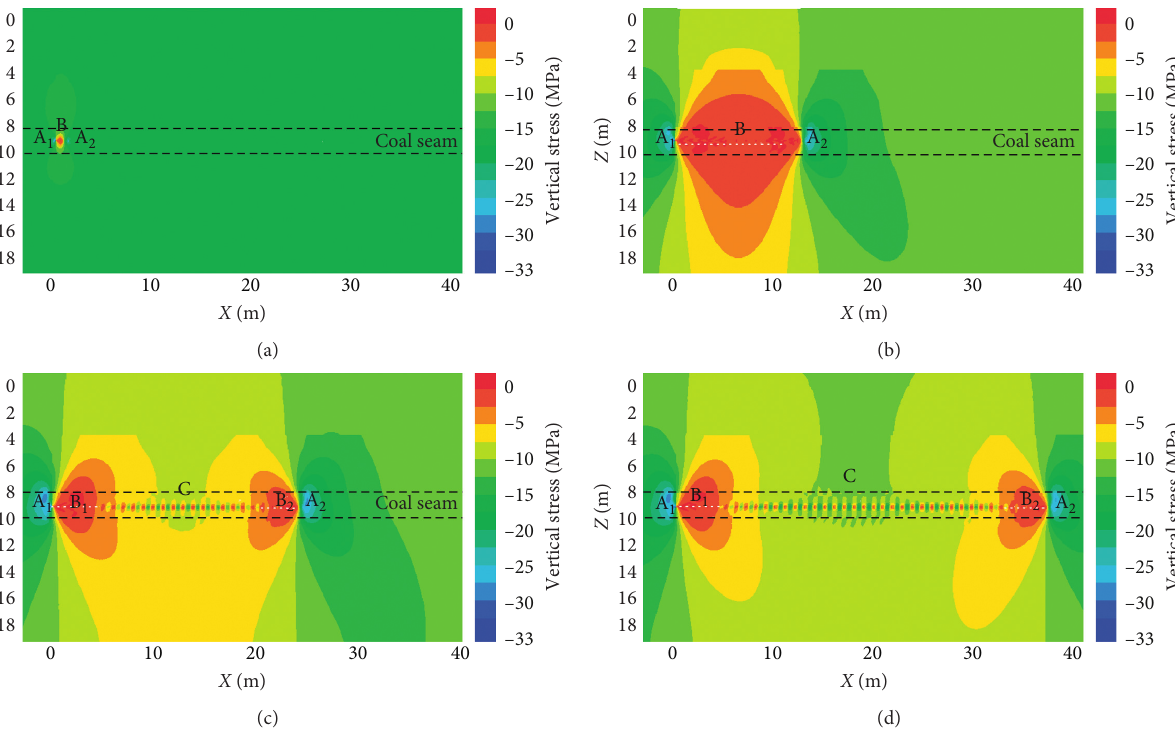
Figure 3: Vertical stress distribution of different slot depths. (a) L � 0.8m, (b) L � 11.2m, (c) L � 22.4 m, and (d) L � 33.6m.